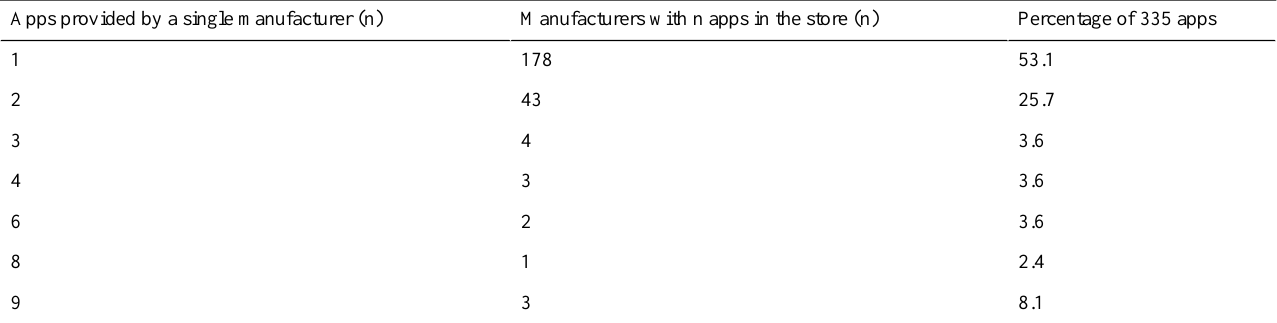
Table 6. The number of apps per